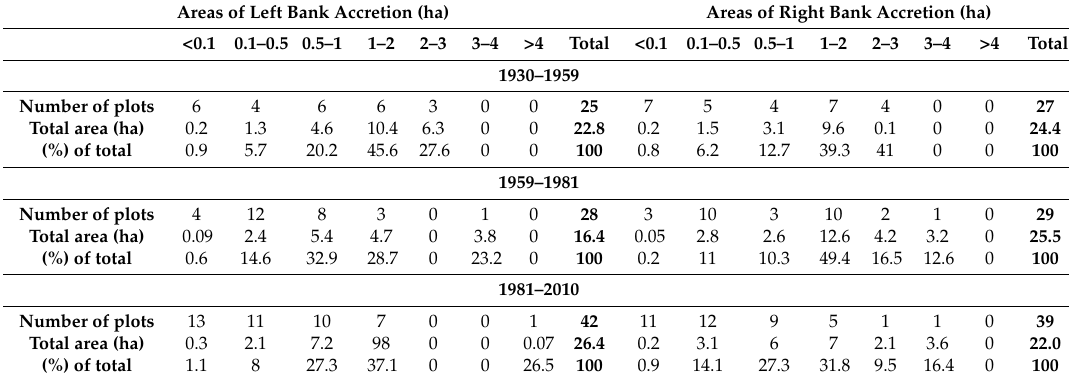
Table 3. Distribution of the accretion